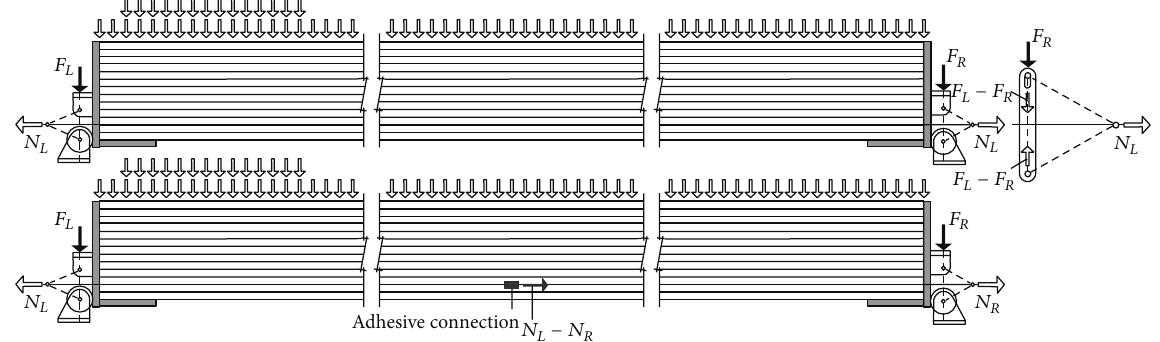
Figure 3: Drawing of lock position at the support (beam above) and tendon anchored in the central section (beam below).